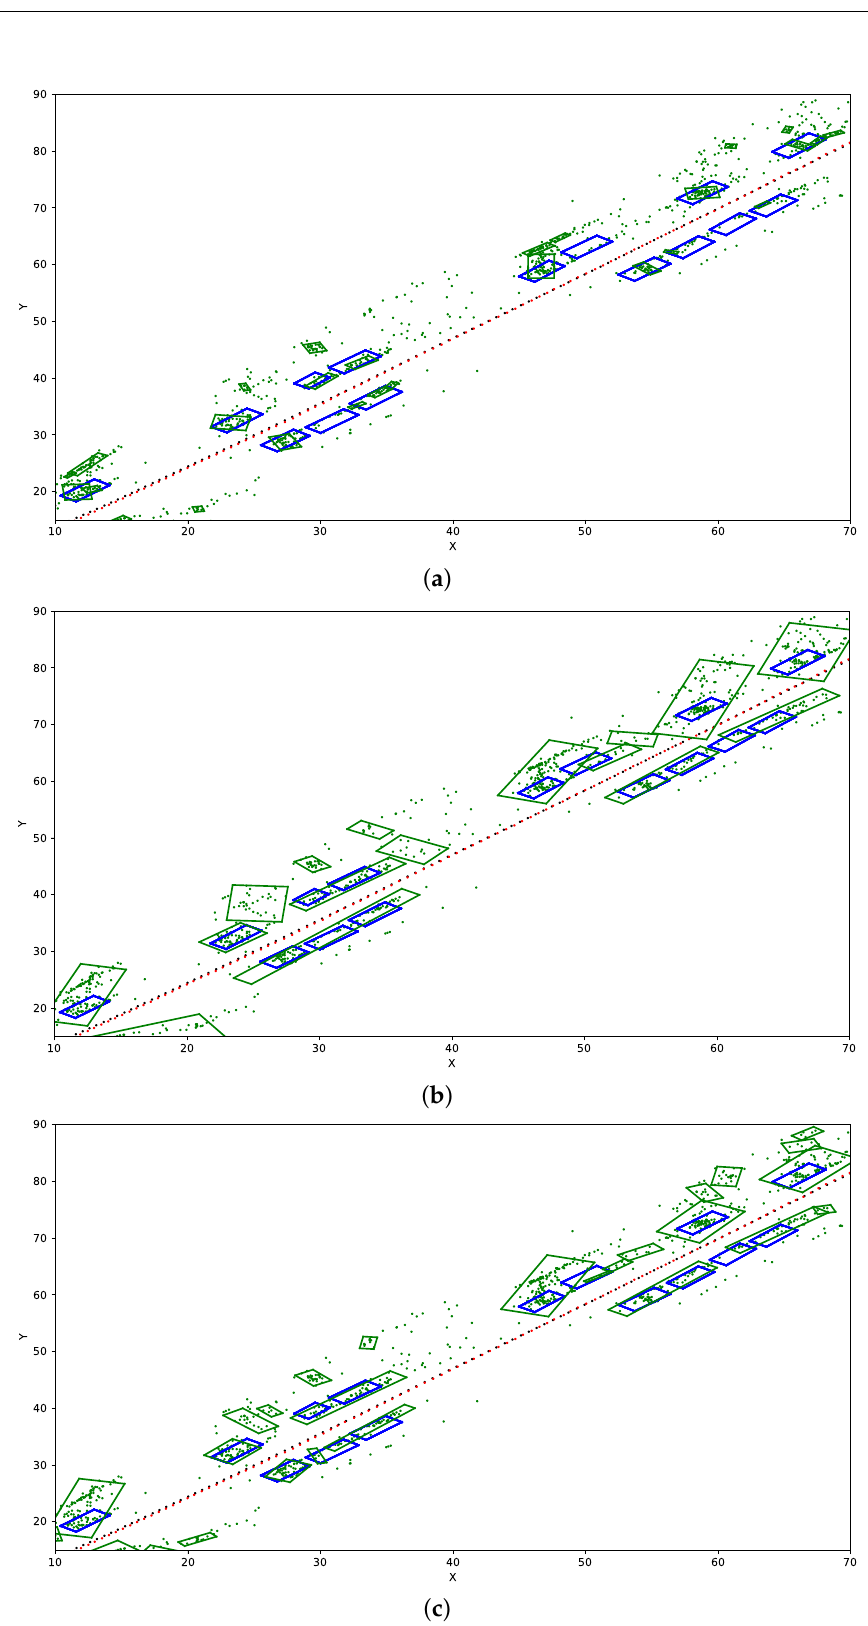
Figure 4. This figure presents influence of application of various DBSCAN parameters on detected objects bounding boxes. Visualization has been done on fragment of the Kitti 39 data set. ( a ) DBSCAN eps = 0.5, min samples = 7. ( b ) DBSCAN eps = 1.5, min samples = 7. ( c ) DBSCAN eps = 1, min samples =